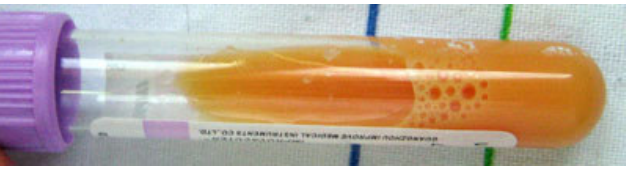
FIGURE 2. Orange pleural